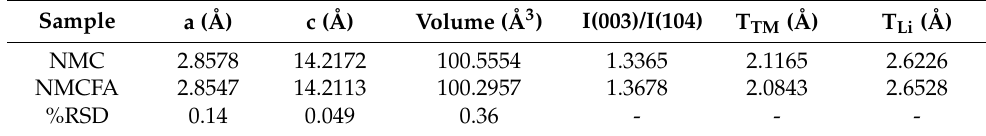
Figure 3. ( a ) XRD patterns of NMC and NMCFA analyzed by Rietveld refinement (NMC: R p = 16.2, R wp = 13.9, and χ 2 = 6.66/NMCFA: R p = 20.3, R wp = 13.7, and χ 2 = 3.35). ( b ) Schematic illustration of a hexagonal lattice. Table 2. Crystallographic parameters and relative standard deviation of the cathode active